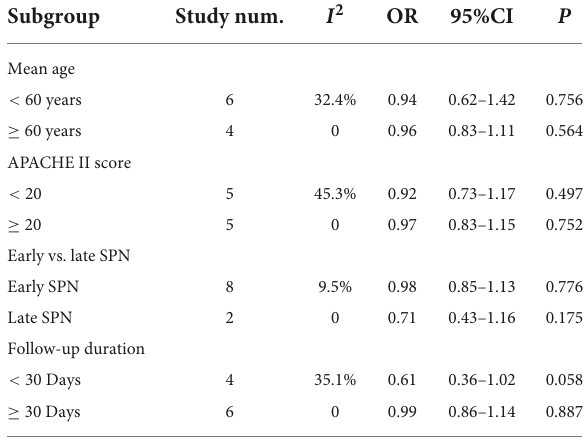
TABLE 2 Meta-regression of baseline data and all-cause mortality. TABLE 3 Subgroup analysis of all-cause